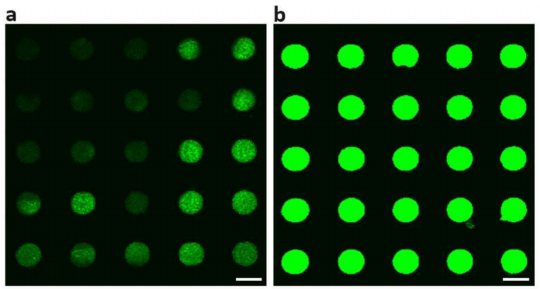
Figure 7. Confocal microscope images showing the non-specific protein adsorption on graphene oxide thin film array. ( a ) Fluorescein isothiocyanate (FITC)-labeled anti- β -hCG adsorbed on graphene oxide thin film array. ( b ) β -hCG adsorbed on graphene oxide thin film array, followed by incubation with FITC-labeled anti- β -hCG. Scale bars: 200 µ m.